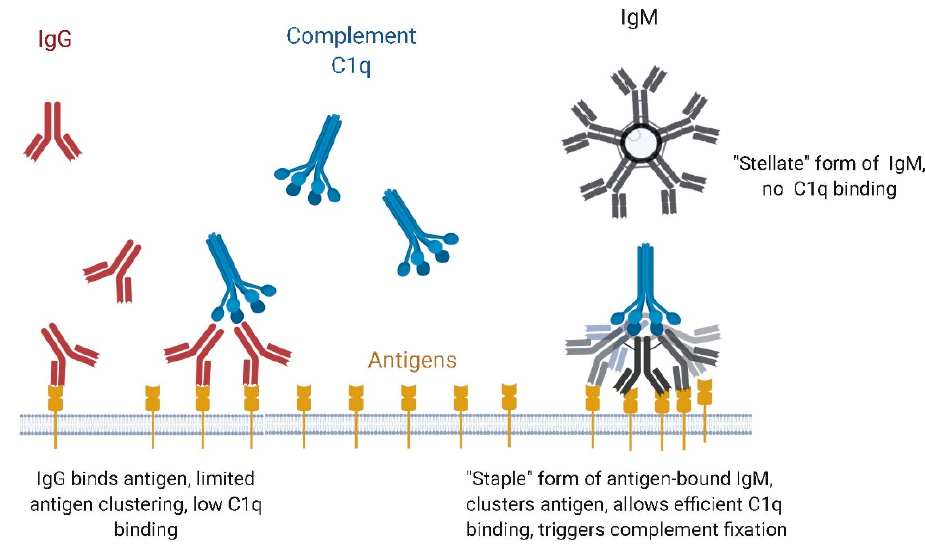
Figure 7. Complement binding and activation with IgM as compared with IgG.